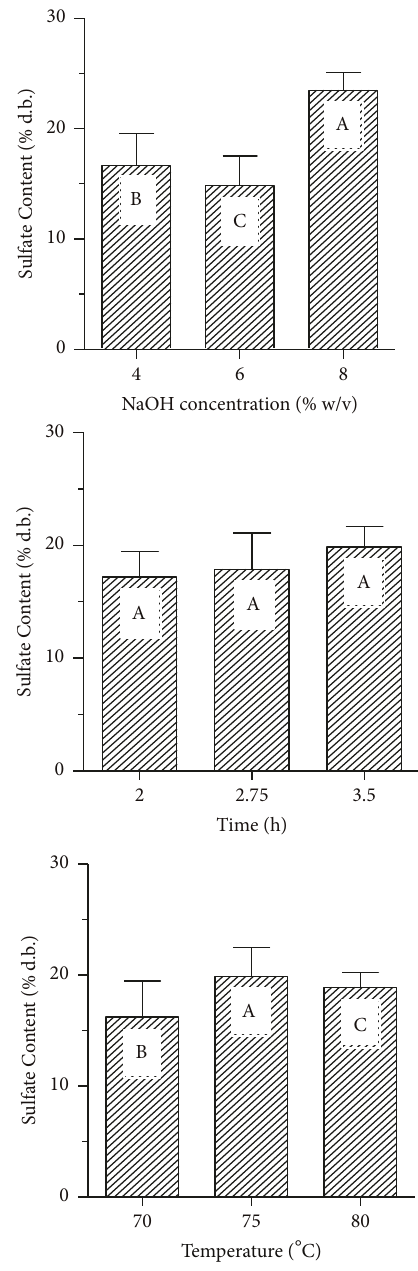
Figure 4: Effects of alkali treatment on sulfate content of car- rageenan extracted from H. bryoides (means with the same letter are not significantly different ( 𝛼 =